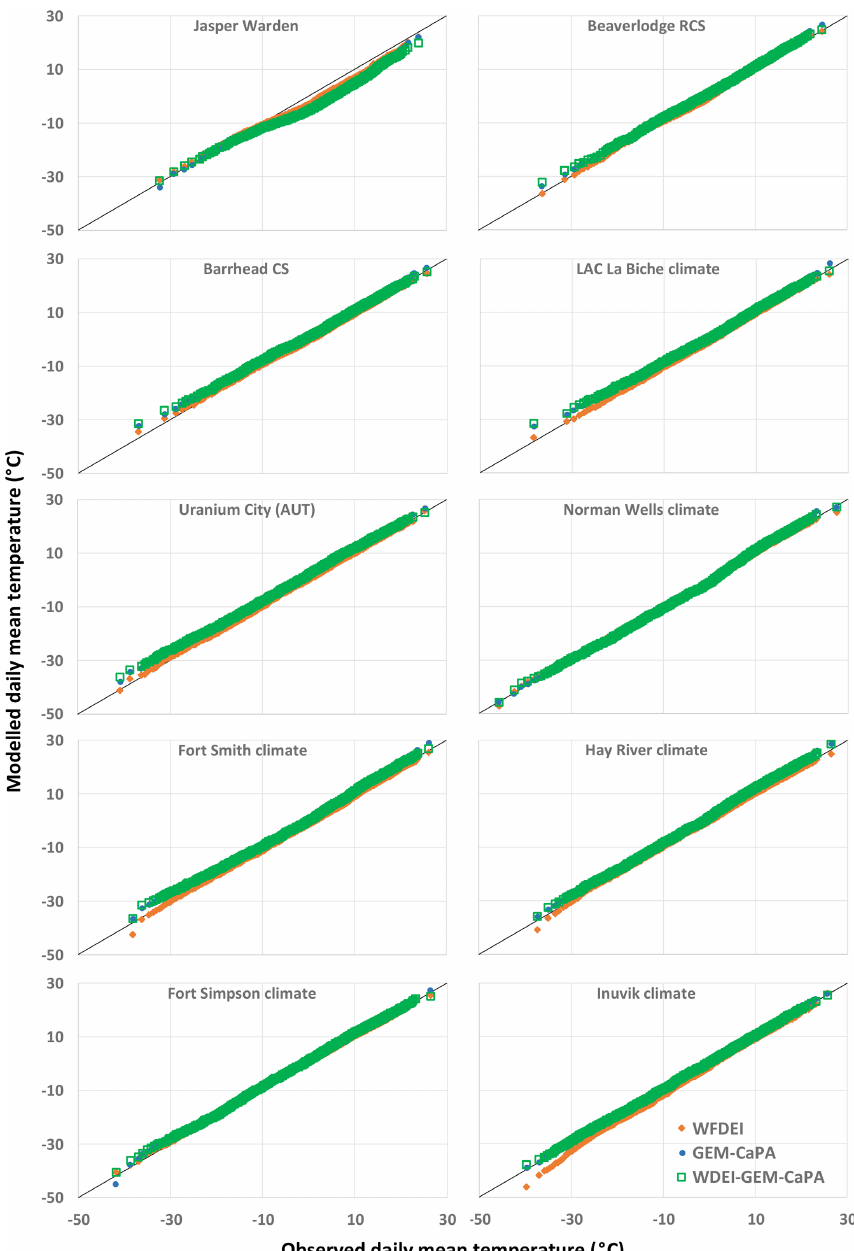
Figure 7. Quantile–quantile plots of modelled (GEM-CaPA, WFDEI, and WFDEI-GEM-CaPA) and observed (ECCC-S) daily mean tem-